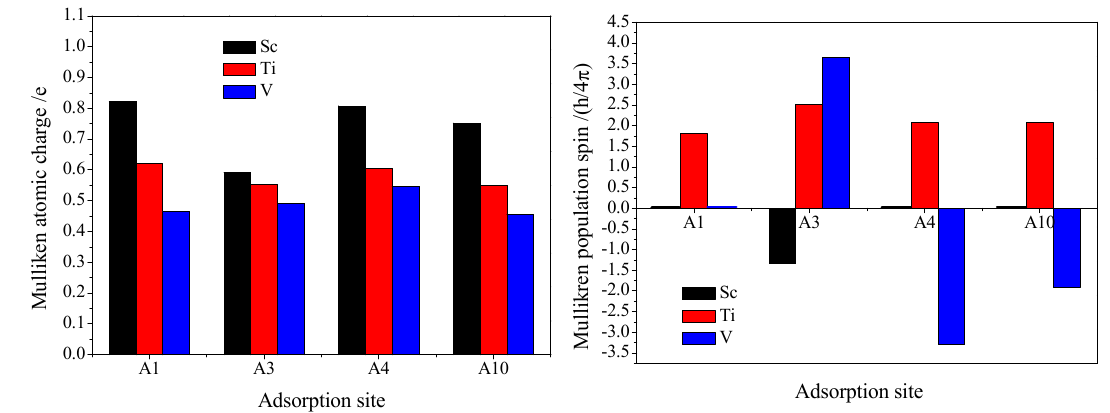
Figure 2. Population Analysis of transition metal-doped ZTC (M-C 39 H 15 , M=Sc, Ti, V): Mulliken atomic charge ( left panel) and spin ( right panel).